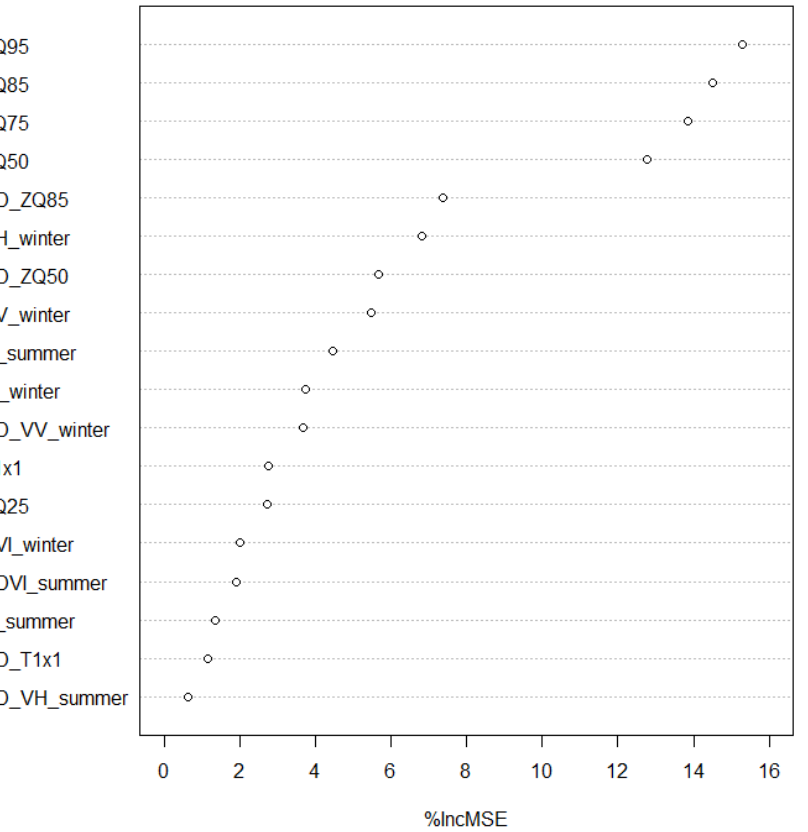
Figure 3. The ranking of feature importance for the Random Forest model. Feature importance is measured as the percent increase in mean-square error (MSE) (%IncMSE) after exclusion of the fea ‐ ture.